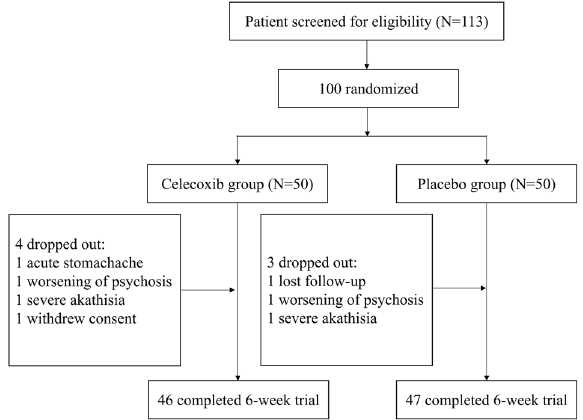
Fig. 1 Flowchart of run-in and maintenance treatment of patients with fi rst-episode drugnaive schizophrenia. IDO: indoleamine 2, 3-dioxygenase enzyme; celecoxib group: schizophrenia patients were treated with celecoxib combination with risperidone; placebo group: schizophrenia patients were treated with placebo combina- tion with risperidone. Table 1. Demographic characteristics and clinical characteristics and serum measures for different subgroups of patients and healthy